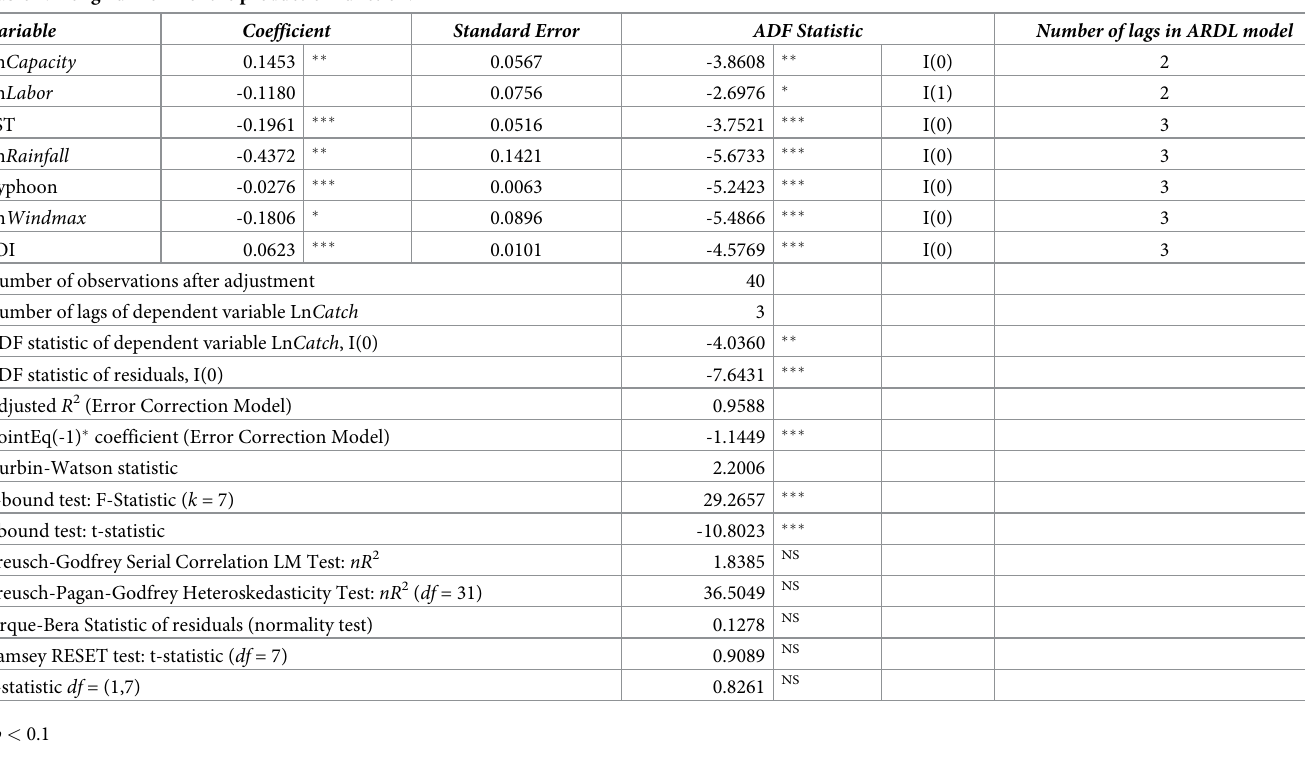
Table 2. Long-run form of the production